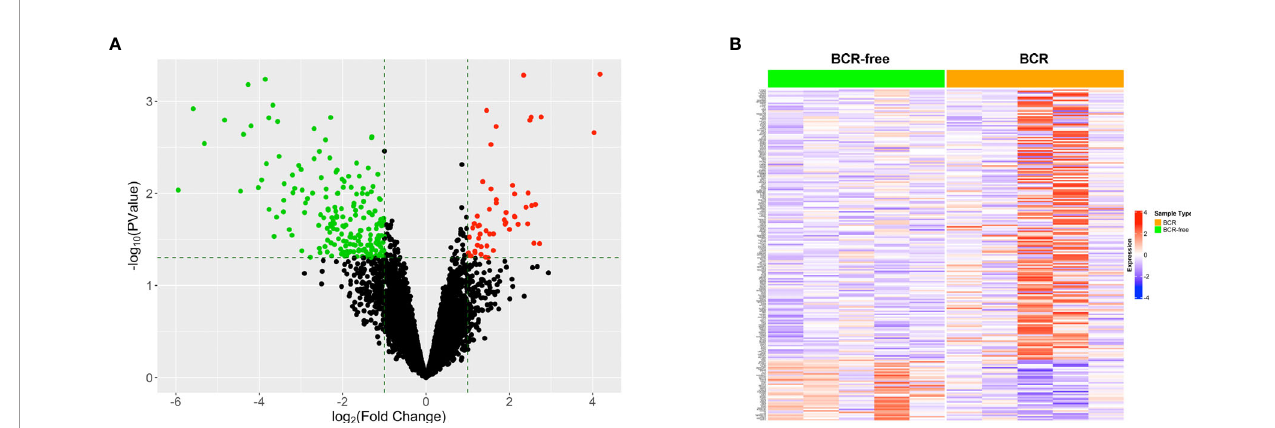
FIGURE 1 | Identi fi cation of the differentially expressed genes between patients who experienced BCR and BCR-free patients using tumor-adjacent normal samples. (A) Volcano plot for the differentially expressed genes. The red/green dot represents upregulated/downregulated genes in the BCR group. The horizontal dashed line represents the cutoff of p < 0.05. The two vertical dashed lines denote the cutoffs of log2 FC < − 1 (left) or log2 FC >1 (right), respectively. (B) Heatmap showing the pro fi les of the differentially expressed genes in TAN tissues between BCR patients and BCR-free patients.